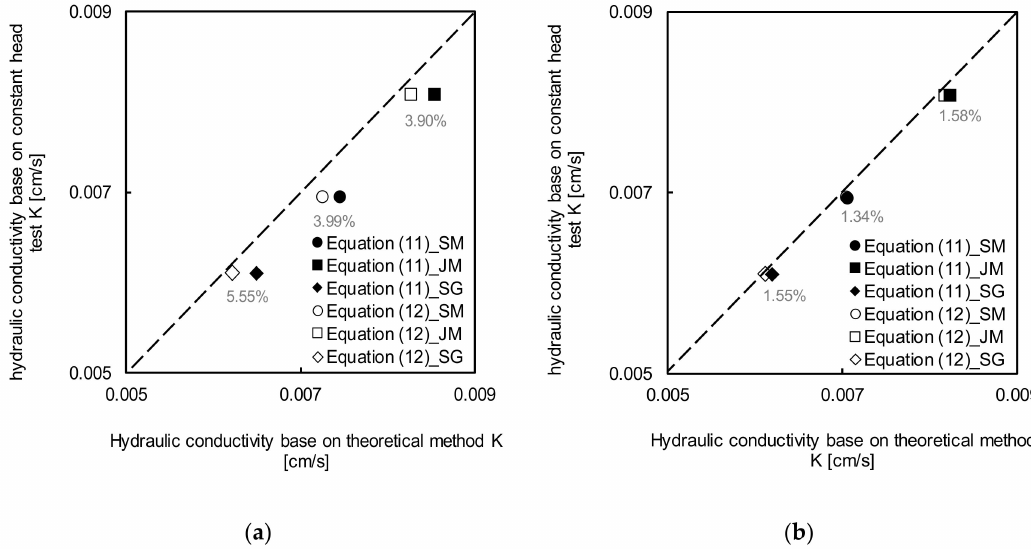
Figure 14. Comparisons of hydraulic conductivity obtained by constant head test and theoretical methods with cementation factor of: ( a ) 1.5; ( b )